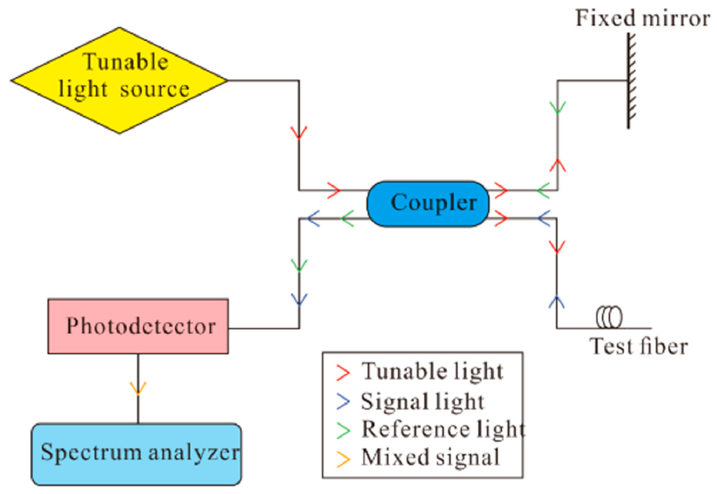
Figure 1. Basical principle of OFDR technology [24].